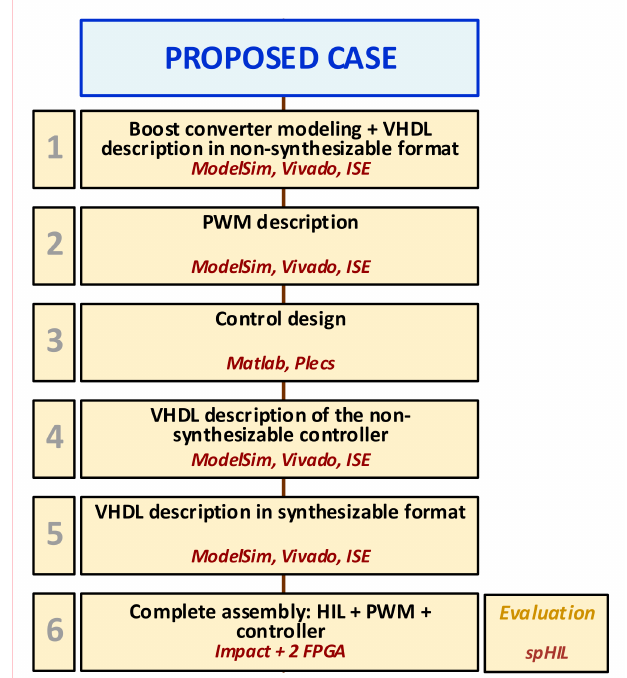
Figure 2. Summary of the proposed case.